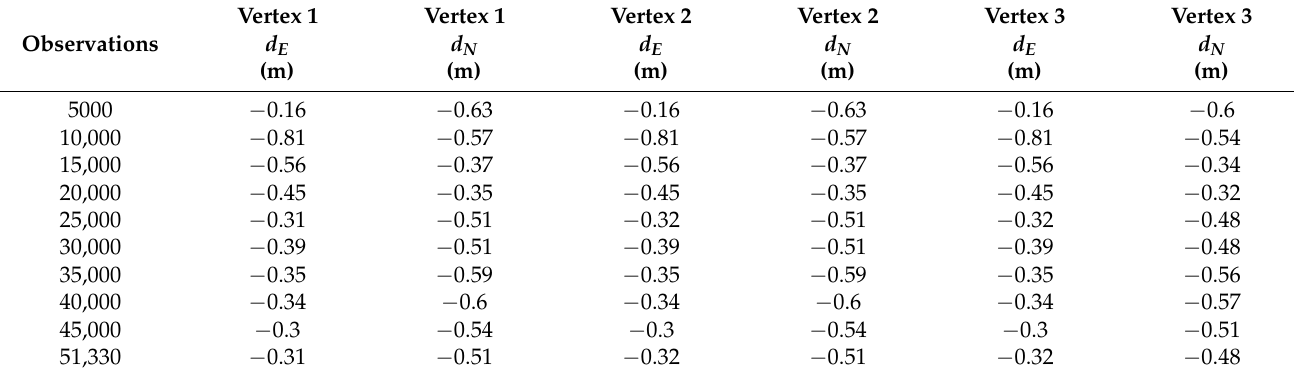
Table 10. The d E , d N error from the East, North coordinates obtained from Equation (27) of different number of observation.